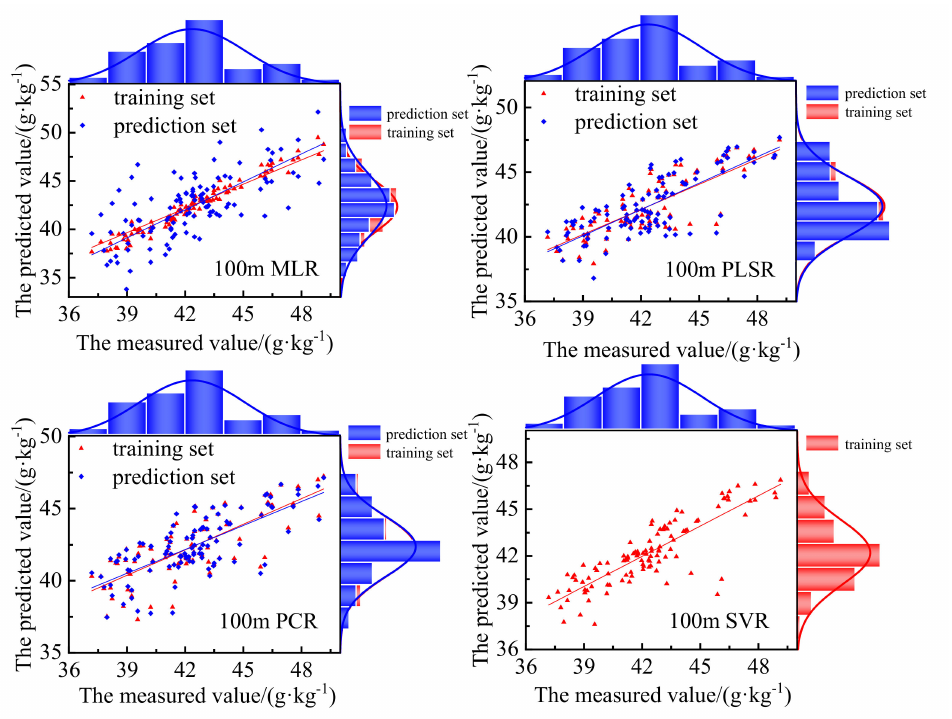
Figure 17. Scatterplots of the measured LNC vs. predicted LNC using multiple modeling methods (60, 80, and 100